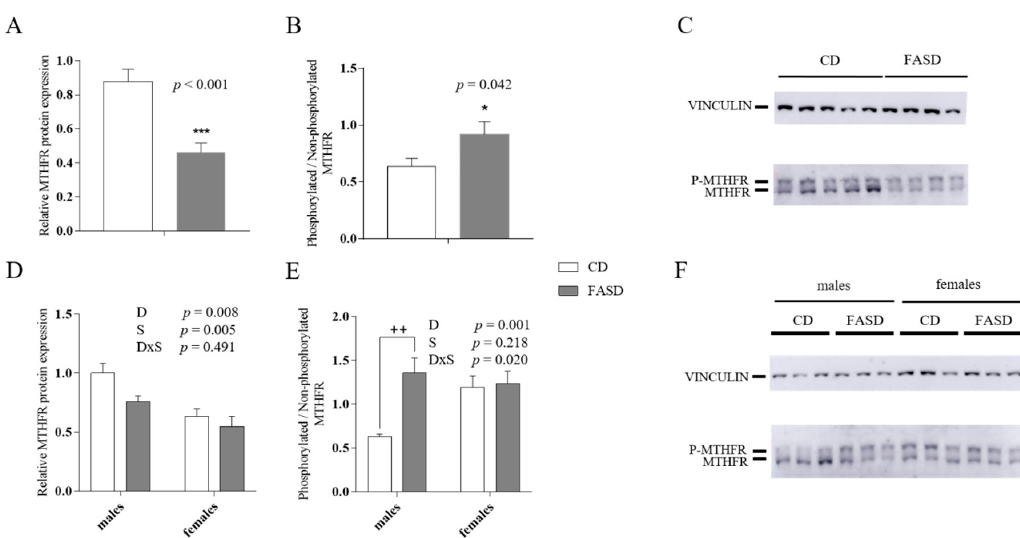
Figure 3. MTHFR protein in maternal and offspring liver. ( A ) Total immunoreactive MTHFR protein (normalized to vinculin expression) was reduced in livers of FASD mothers ( n = 9–10 / group). ( B ) The ratio of the phosphorylated isoform (less active) to the non-phosphorylated isoform was increased in FASD mothers ( n = 10 / group). ( C ) Representative Western blot of liver extracts from CD and FASD mothers. ( D ) Total immunoreactive MTHFR protein (normalized to vinculin expression) was reduced in livers of FASD pups compared to CD pups, and in female pups compared to male pups ( n = 5–7 / group). ( E ) The ratio of the phosphorylated isoform to the non-phosphorylated isoform was increased in FASD male pups ( n = 5–7 / group). ( F ) Representative Western blot of liver extracts from 4-week-old male and female pups. White bars: CD animals, gray bars: FASD animals. Values are means ± SEM. In graphs ( A , B ), asterisks correspond to t -test associated p values, * p < 0.05, *** p < 0.001. In graphs ( C , D ), p values from 2-factor ANOVA are indicated at the top of each graph, and Tukey post-hoc significant p values are indicated as ++ p < 0.01. CD: Control diet, FASD: Folic acid supplemented diet, D: Diet, S: Sex, D × S: Diet × Sex interaction, P-MTHFR, phosphorylated MTHFR